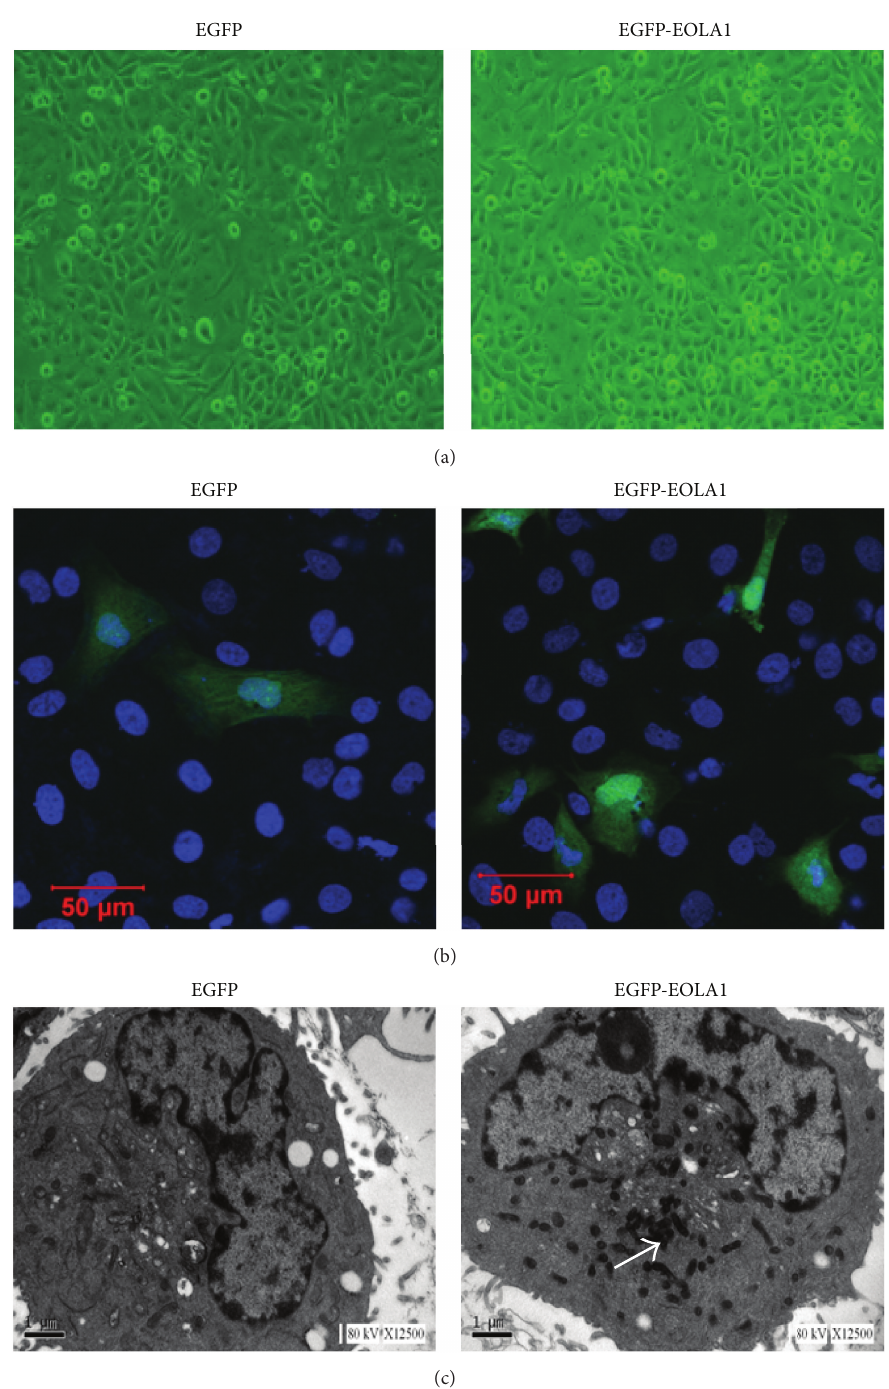
Figure 1: Subcellular location of EOLA1 is indicated in ECV304 cells. ECV304 cells were transfected with the blank plasmid pEGFP-N2 and the fusion protein expression plasmid pEGFP-EOLA1. After 48 h culture, the transfected cells were fixed with 4% PFA. (a) The images of ECV304 cells were taken under the optical microscope. (b) The cells were incubated with rat anti-GFP antibody (primary antibody) and goat anti-rat antibody (secondary antibody), stained with DAPI, and photographed under LSM510 META laser confocal microscope. (c) The cells were incubated with rabbit anti-EOLA1 polyclonal antibody (primary antibody) and HRP-labeled goat anti-rabbit IgG antibody (secondary antibody), stained with HRP-labeled streptoantibiotin and diaminobenzidine, and embedded with epoxy resin 618. Finally the cells were made into ultrathin sections, stained with lead, and observed and photographed under TECNA110 transmission electron microscope. The white arrow identifies immune sediment deposition in ECV304 cells transfected with pEGFP-EOLA1 by anti-EOLA1